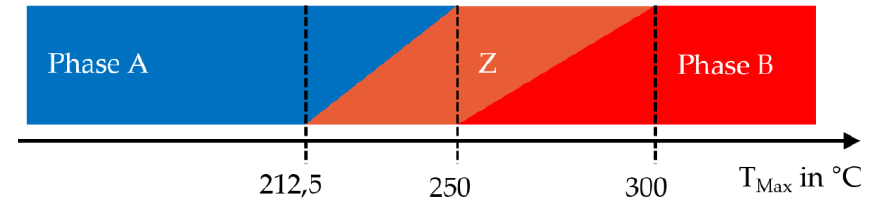
Figure 8. Schematic temperature transformation ranges of the imaginary phases for alloy 6060 T4.